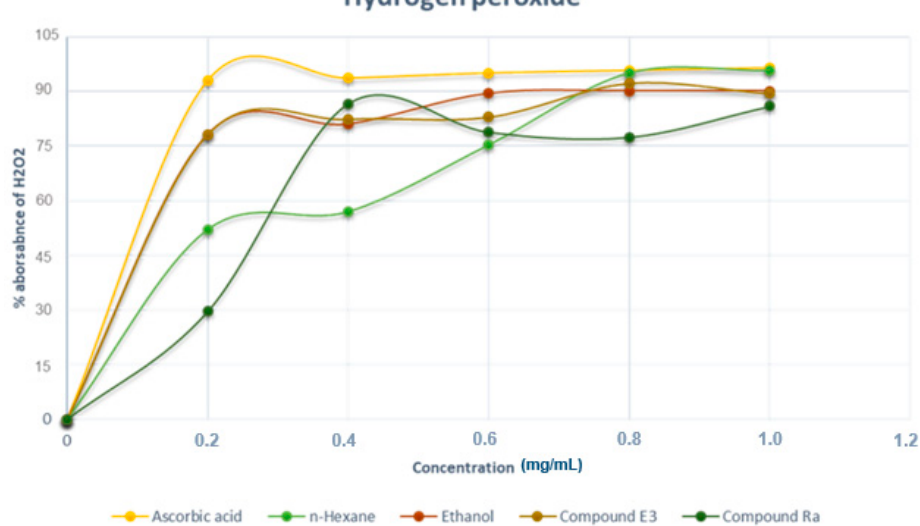
Figure 9. Scavenging activity (%) of H 2 O 2 of M. oleifera extracts and pure compounds. Data are presented as the percentage of H 2 O 2 radical scavenging. Each value is expressed as mean ± standard deviation ( n = 3).